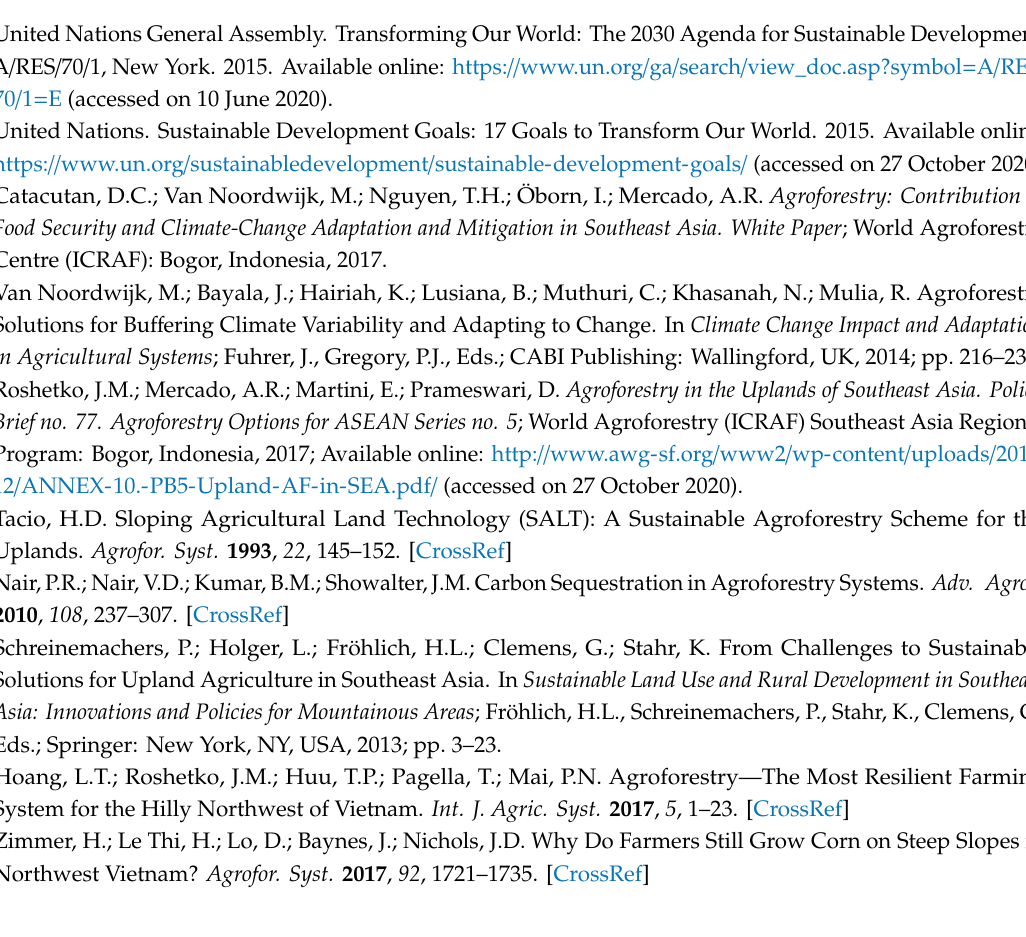
Table S1: Fertilisation regime applied in the sole-crop and agroforestry systems in Van Chan and Tuan Giao; Table S2: Cost of cropping inputs and prices paid for products at the study sites, 2012–2018 (data provided by the provincial extension department); Table S3: Groups selected for farmer group discussions (FGD); Table S4: List of questions used in farmer group